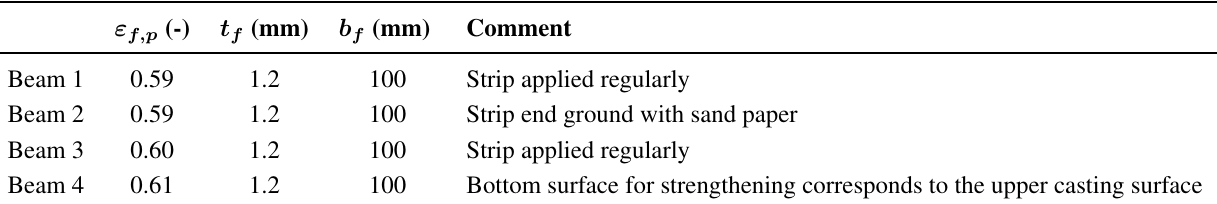
Table 3. Retrofitting